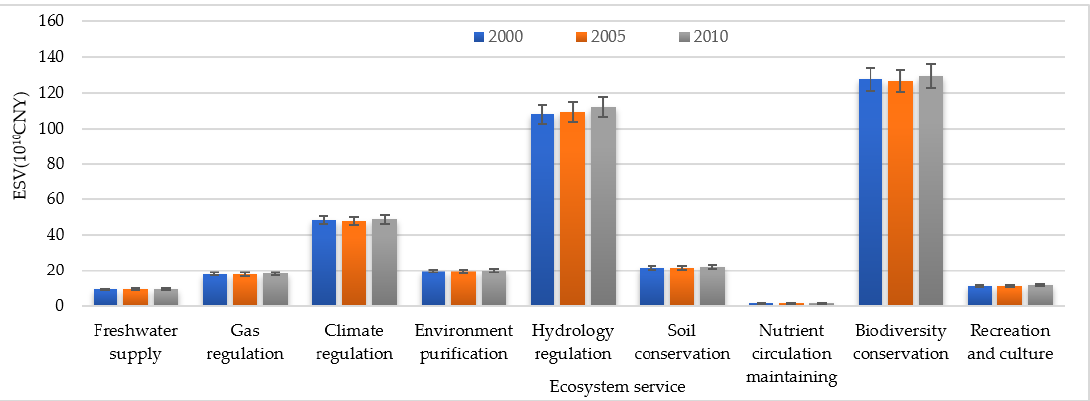
Figure 7. Ecosystem services value of each ecosystem service function in the national nature reserves in western China.